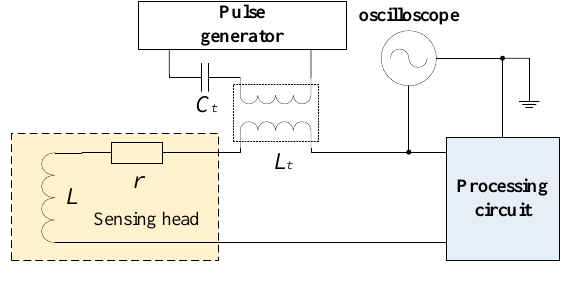
Figure 22. Jamming input method.